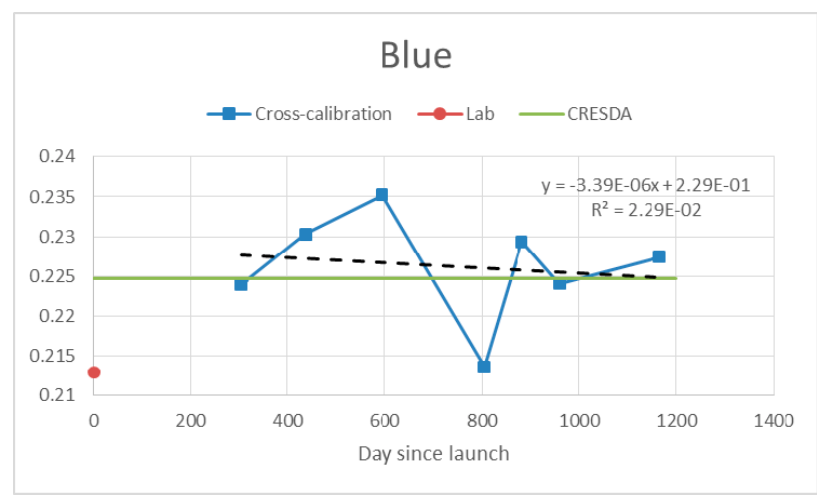
Figure 8. Time-dependent variation of cross-calibration coefficients in GF-1 PMS1 Blue band. ’Lab’ represents the laboratory calibration coefficients of blue band; ‘CRESDA’ represents the site calibration coefficients of blue band.